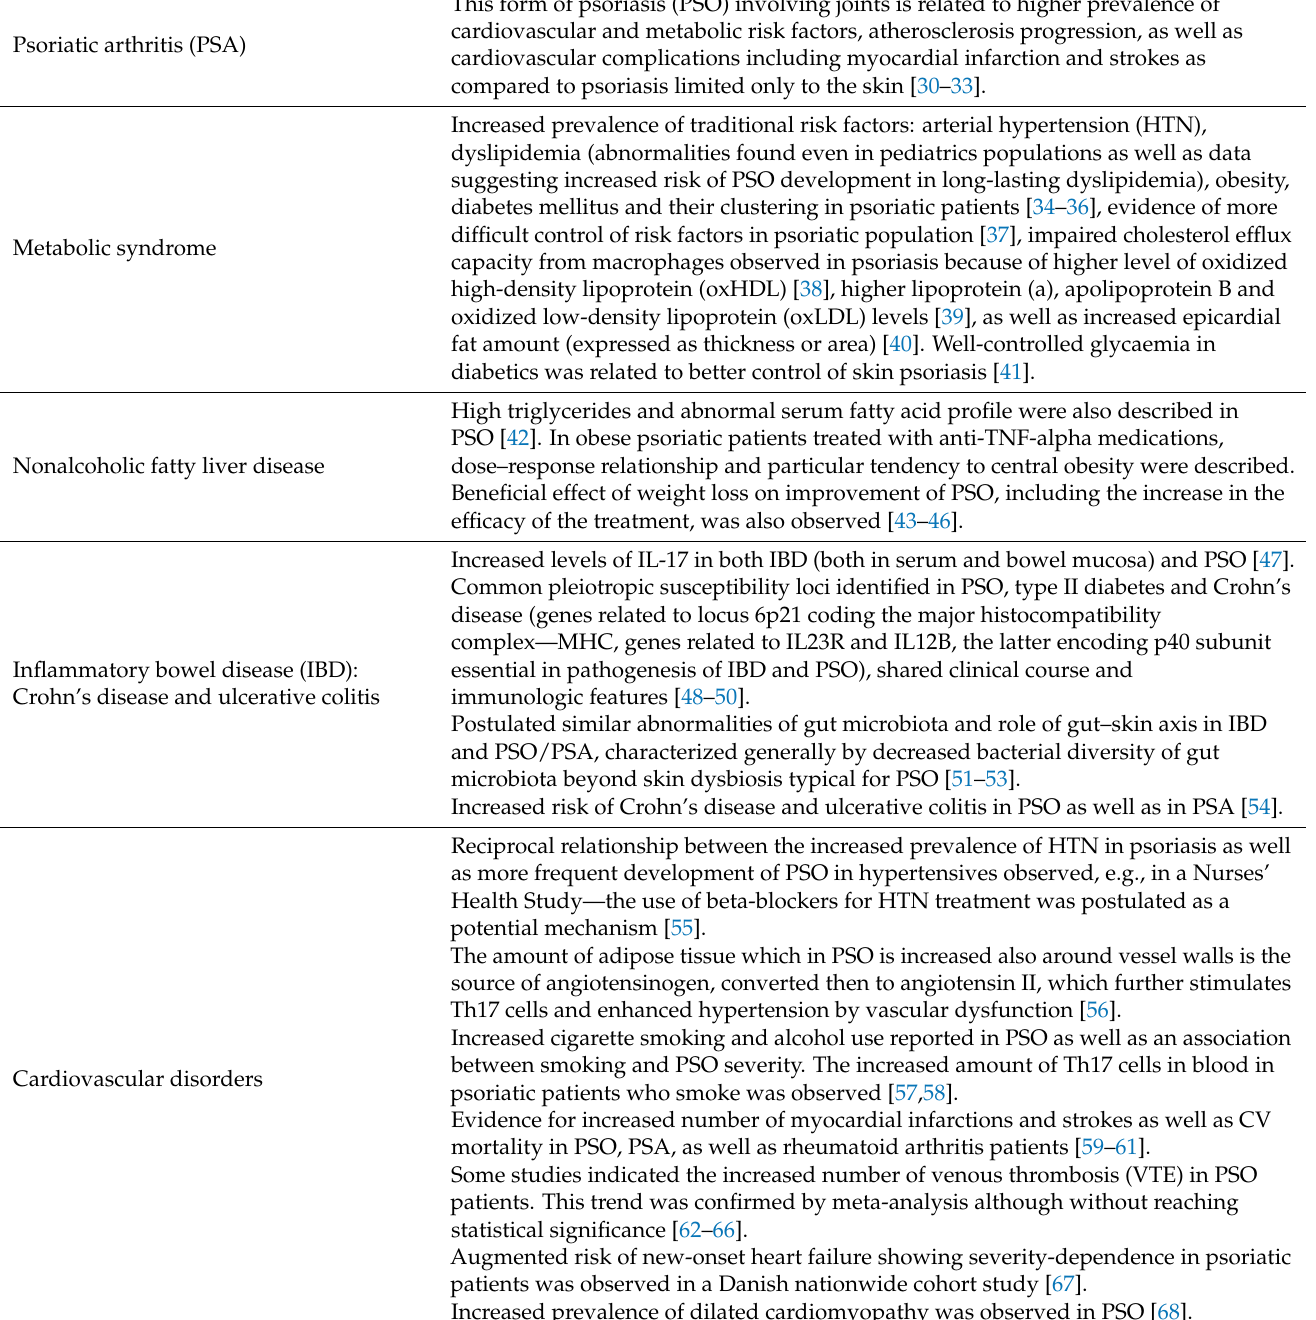
Table 1. Comorbidities in psoriatic patients and their postulated pathophysiological links. Disease/State Related to